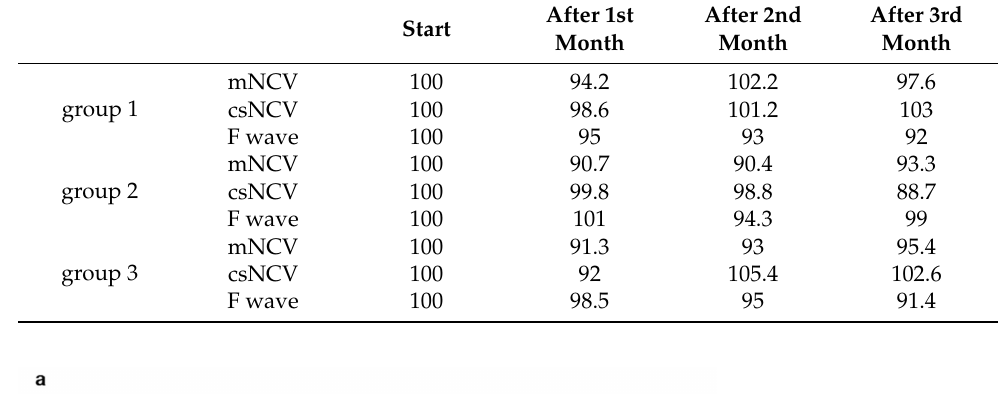
Table 3. Averaged values of mNCV (motor nerve conduction velocity), csNCV (combined sesorimotor nerve conduction velocity) and minimum F wave latencies for the three rat groups (group 1, n = 12; group 2, n = 10; group 3, n = 16) over three months shown as normalized to 100% of the initial value.